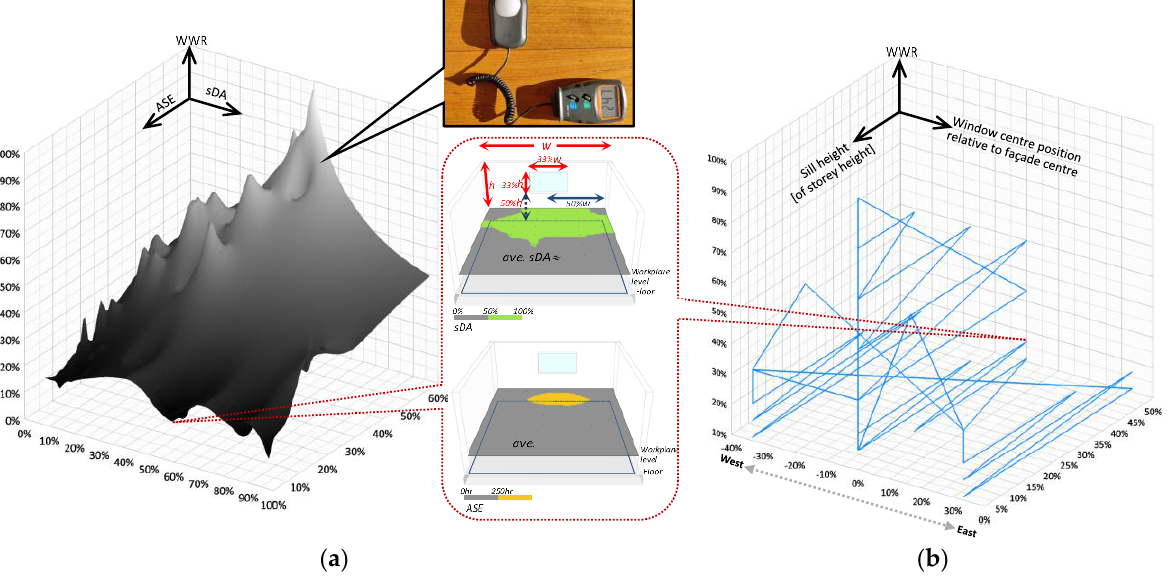
Figure 6. Acceptable ranges for: ( a ) sDA and ASE according to WWR; and ( b ) window position according to WWR. The surface and line graphs represent the acceptable configurations.